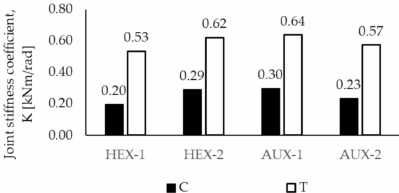
Figure 9. Sti ff ness coe ffi cient K of corner joints in compression (C) and tension (T)